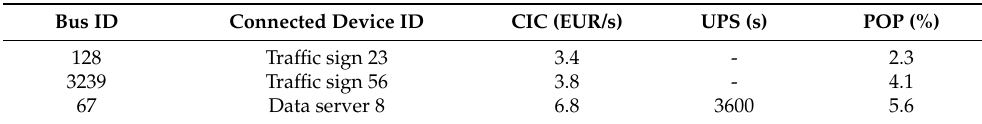
Table 4. Example of a table summarizing parameters of particular point of delivery for the economic